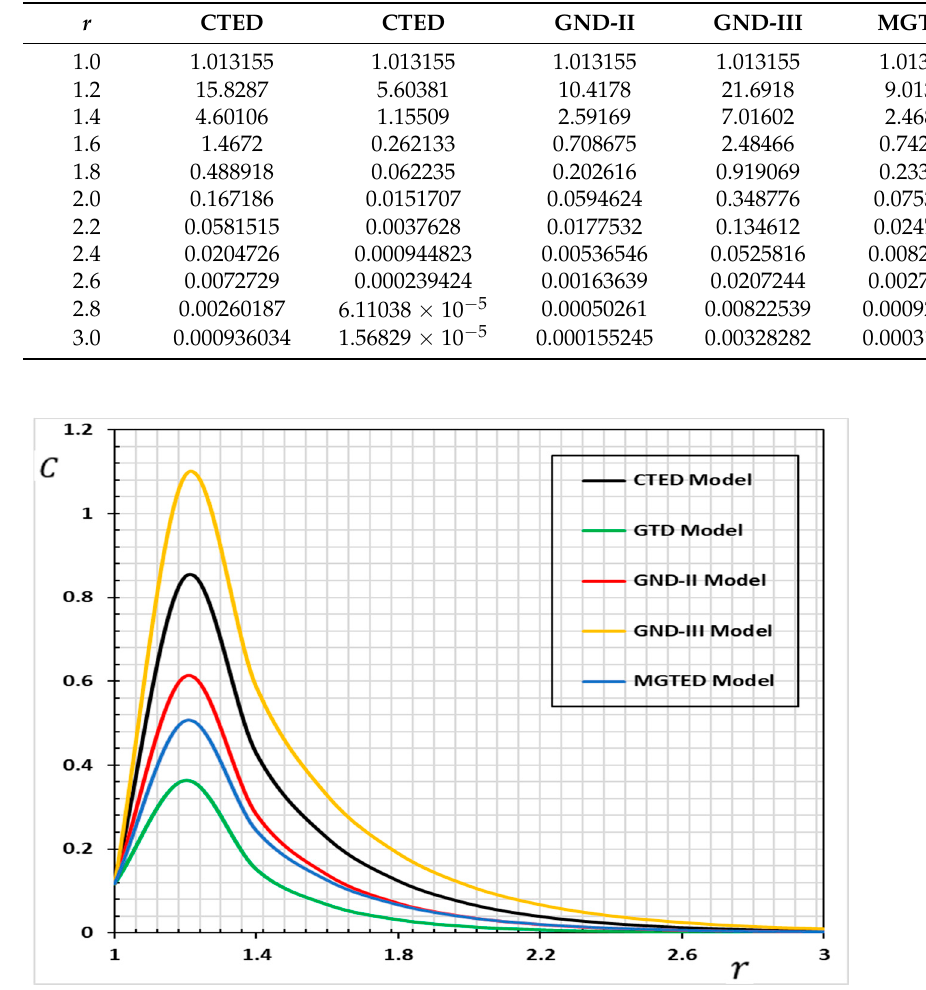
Figure 6. The concentration 𝐶 for different thermo-diffusion models.